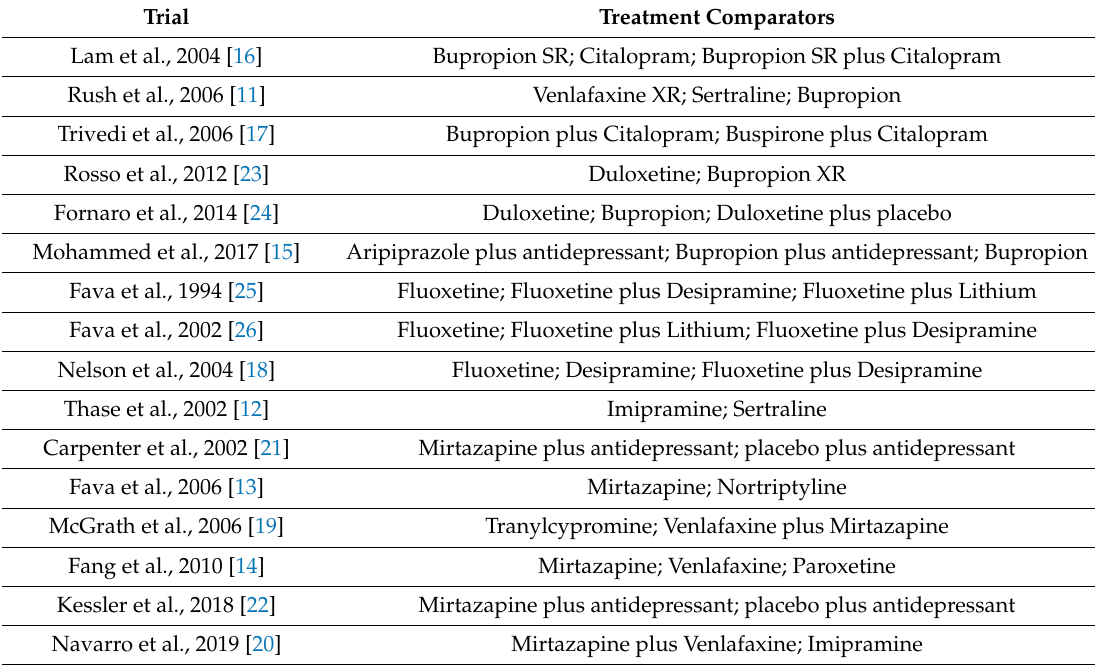
Table 3. List of Included Antidepressant